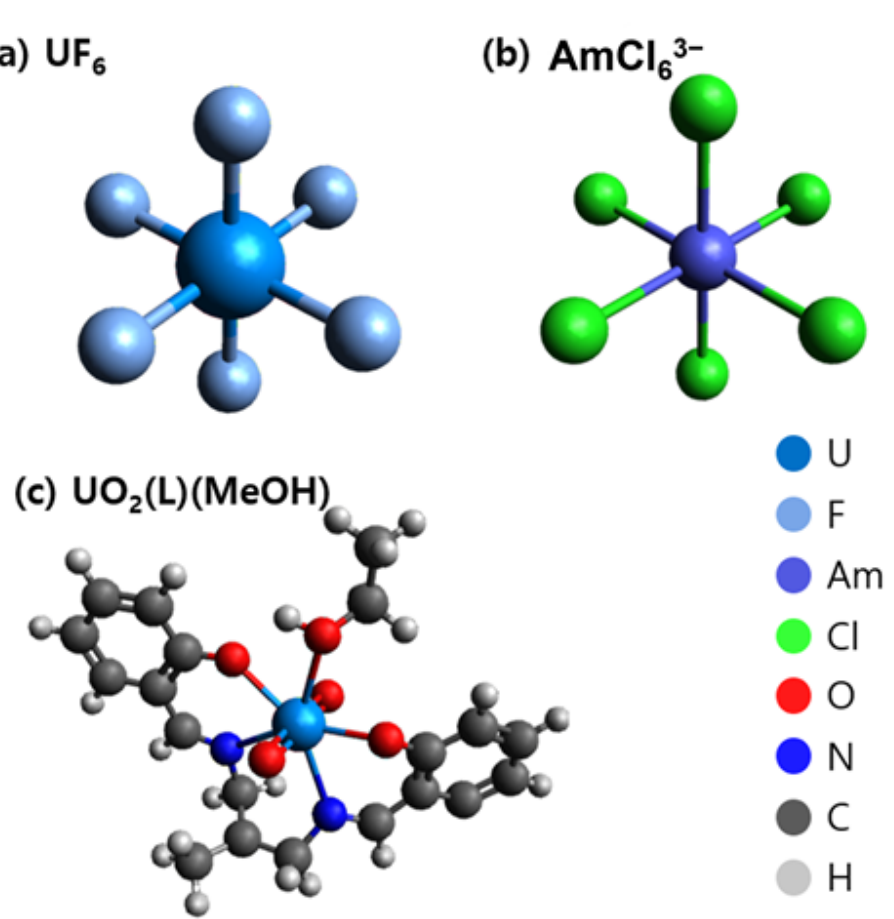
Figure 1. Molecular structure of ( a ) UF 6 , ( b ) AmCl 63 − , and ( c ) UO 2 (L)(MeOH)